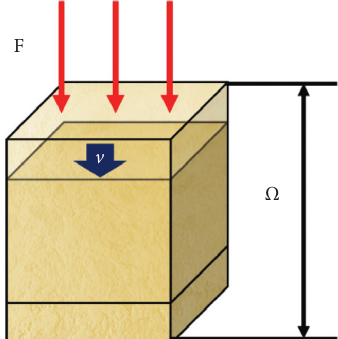
Figure 5: Principle of work done by gravity of soil.